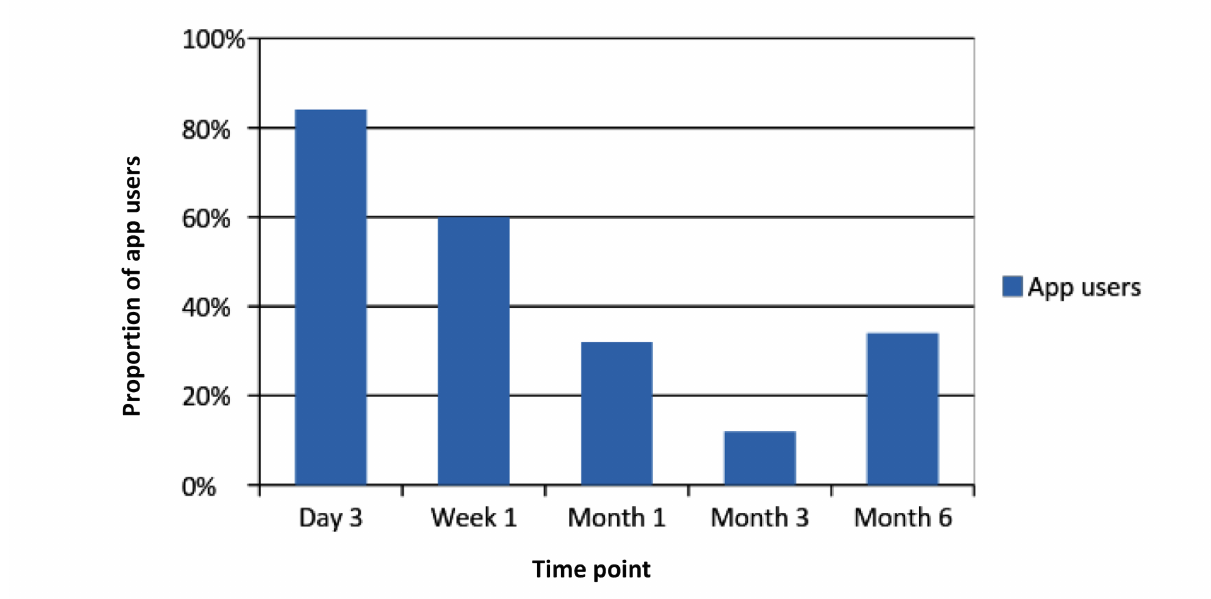
Figure 2. Proportion of app users during